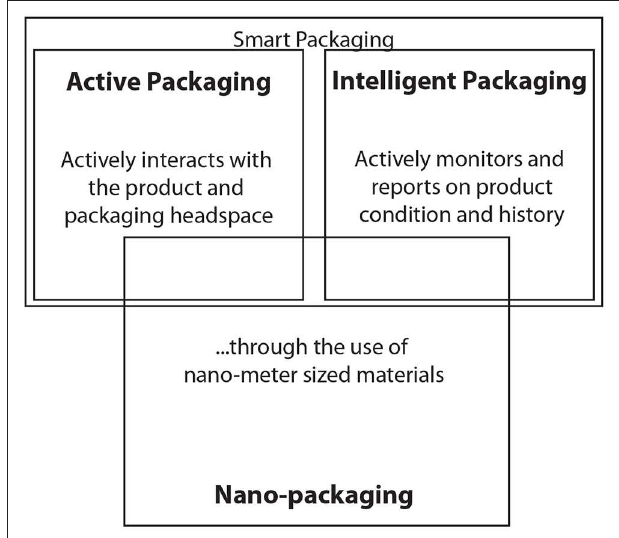
FIGURE 1 | The relationships between smart, active, intelligent, and nano-packing